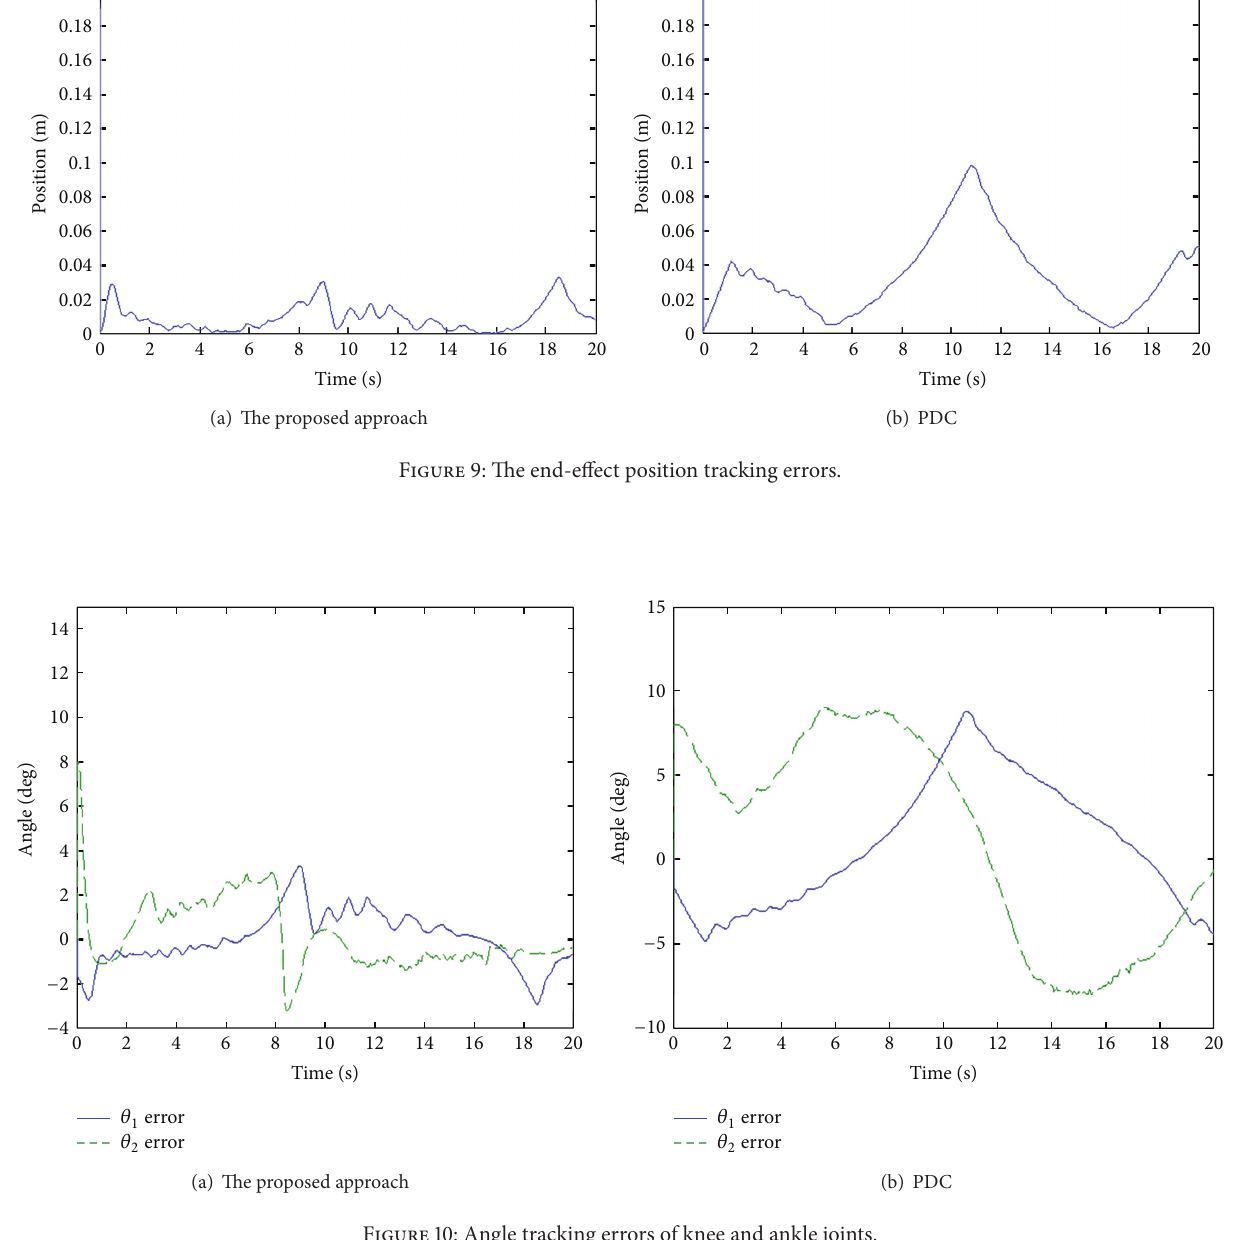
Figure 10: Angle tracking errors of knee and ankle